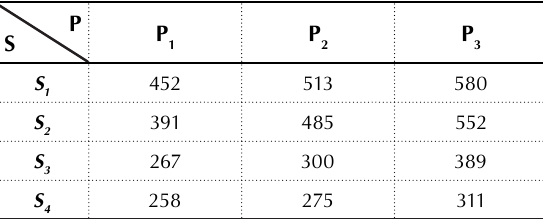
Table 3. PI – profitability index of projects